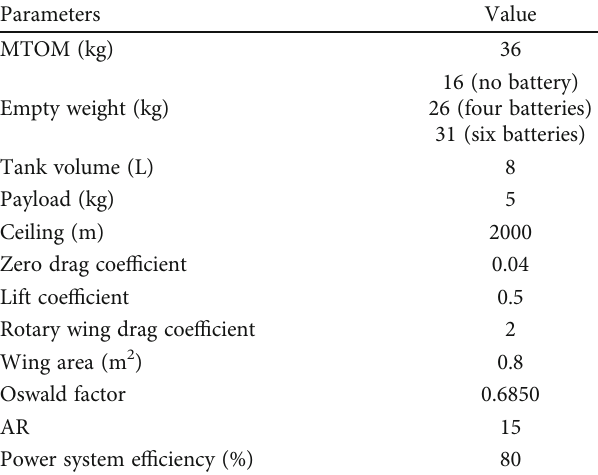
Figure 5: Flight pro fi le diagram. Table 2: Basic parameters of prototype.